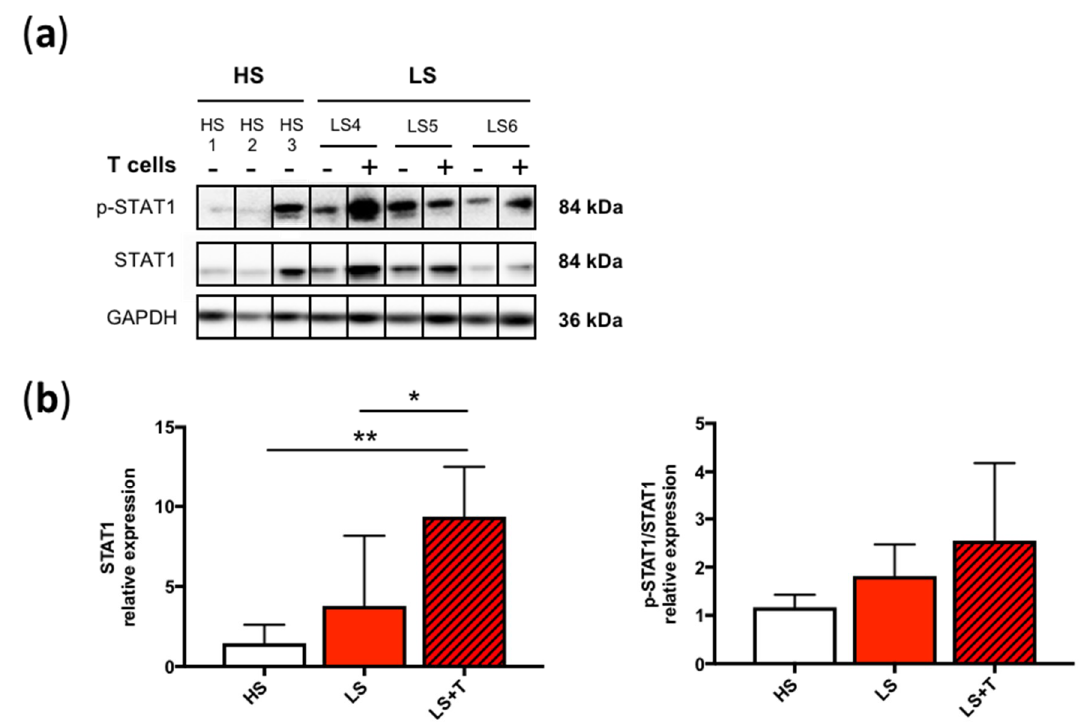
Figure 5. T cells induced immune-dependent STAT1 signaling in tissue-engineered skin models. ( a ) Western Blot and ( b ) quantification of STAT1 (relative to GAPDH), and phospho-STAT1 (p-STAT1)/STAT1 in healthy (HS), lesional (LS) and lesional with T cells (LS + T) tissue-engineered skin models. Significant differences (* p < 0.05, ** p < 0.01, **** p < 0.0001) are indicated by an asterisk. Error bars represent SD ( n = 3). HS1, HS2, and HS3 refer to healthy patients 1, 2, and 3. LS4, LS5, and LS6 refer to psoriatic patients 4, 5, and 6.